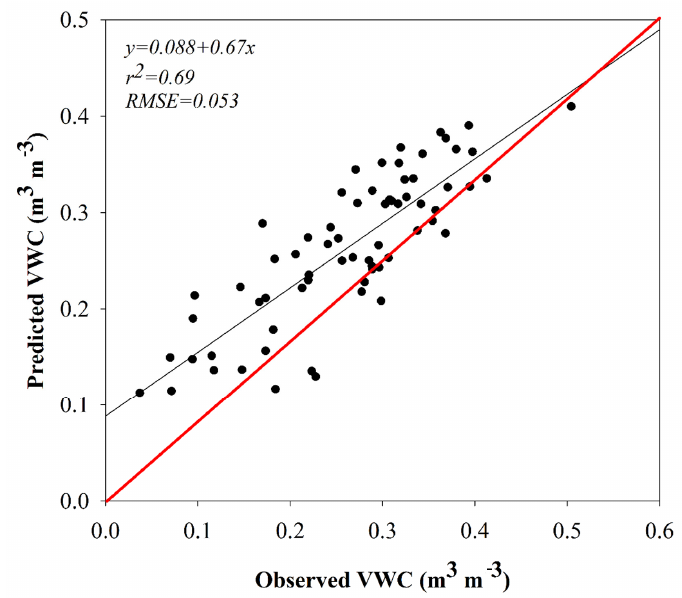
Figure 9. Scatter plot showing observed versus predicted volumetric water content (m 3 m − 3 ) during the testing phase along with regression coefficient (r 2 ) and root mean square error (RMSE) for random forest regression model.